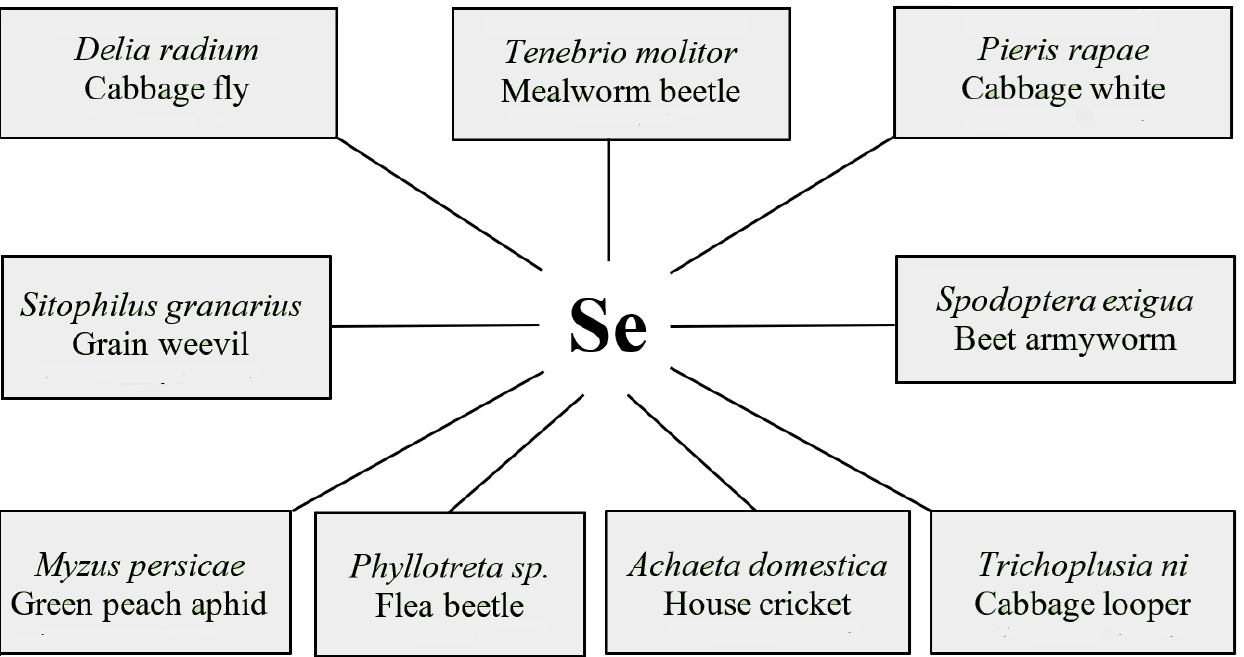
Figure 2. Examples of plant protection against herbivory using selenium